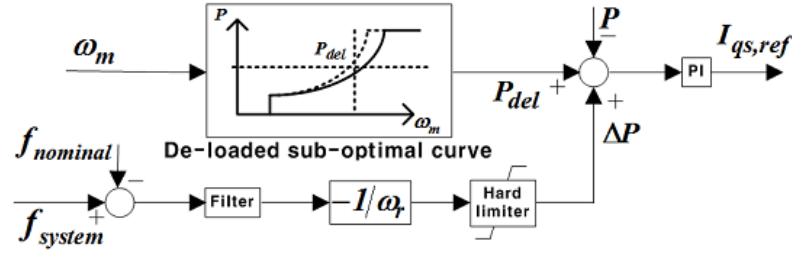
Figure 4. Configuration of the DL